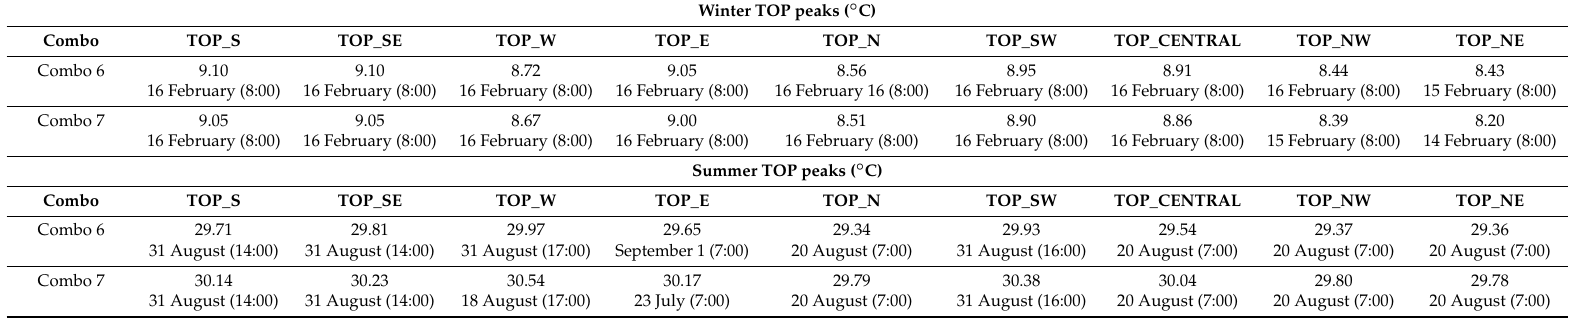
Table 11. Fourth step: TOP yearly peaks (in bold lowest values in winter and highest values in